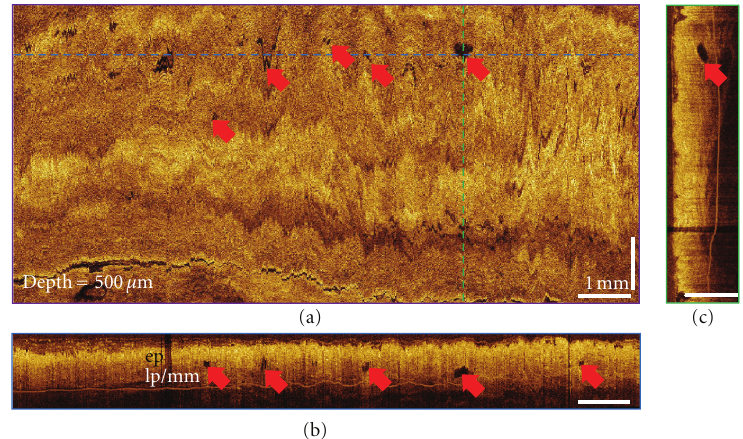
Figure 1: 3D-OCT orthoplanes from the BE region before RFA treatment. (a) The en face orthoplane is located at a depth of 500 µ m. The colored dotted lines indicate location of complementary orthoplanes (b) and (c). Red arrows indicate the locations of the BE glands. (b) The cross-sectional YZ orthoplane shows the epithelium (ep), lamina propria (lp), and muscularis mucosa (mm). (c) The cross-sectional XZ orthoplane shows the hyposcattering feature of the BE glands on top of the lp/mm layer.